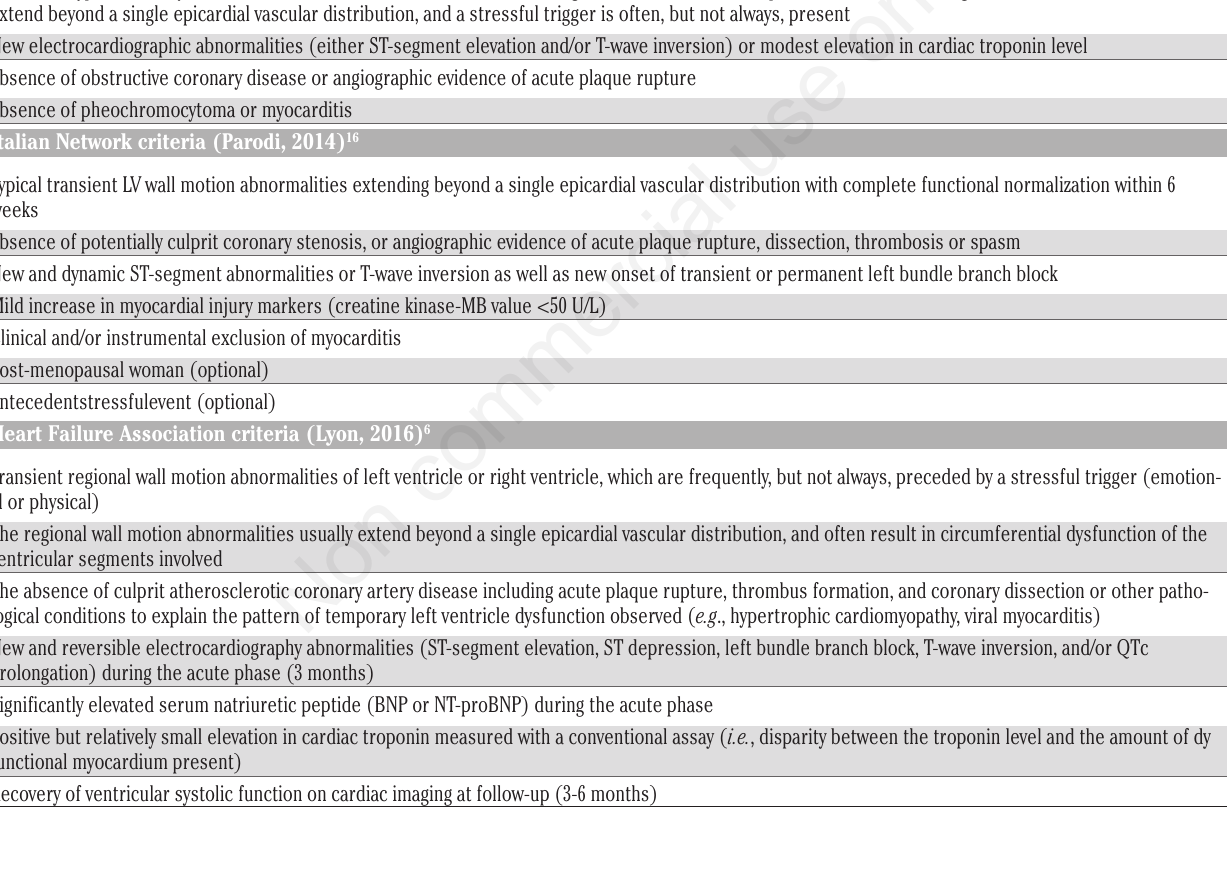
Table 2. Summary of proposed pathophysiological hypothesis and of predisposing factor for Takotsubo syndrome. Pathophysiological